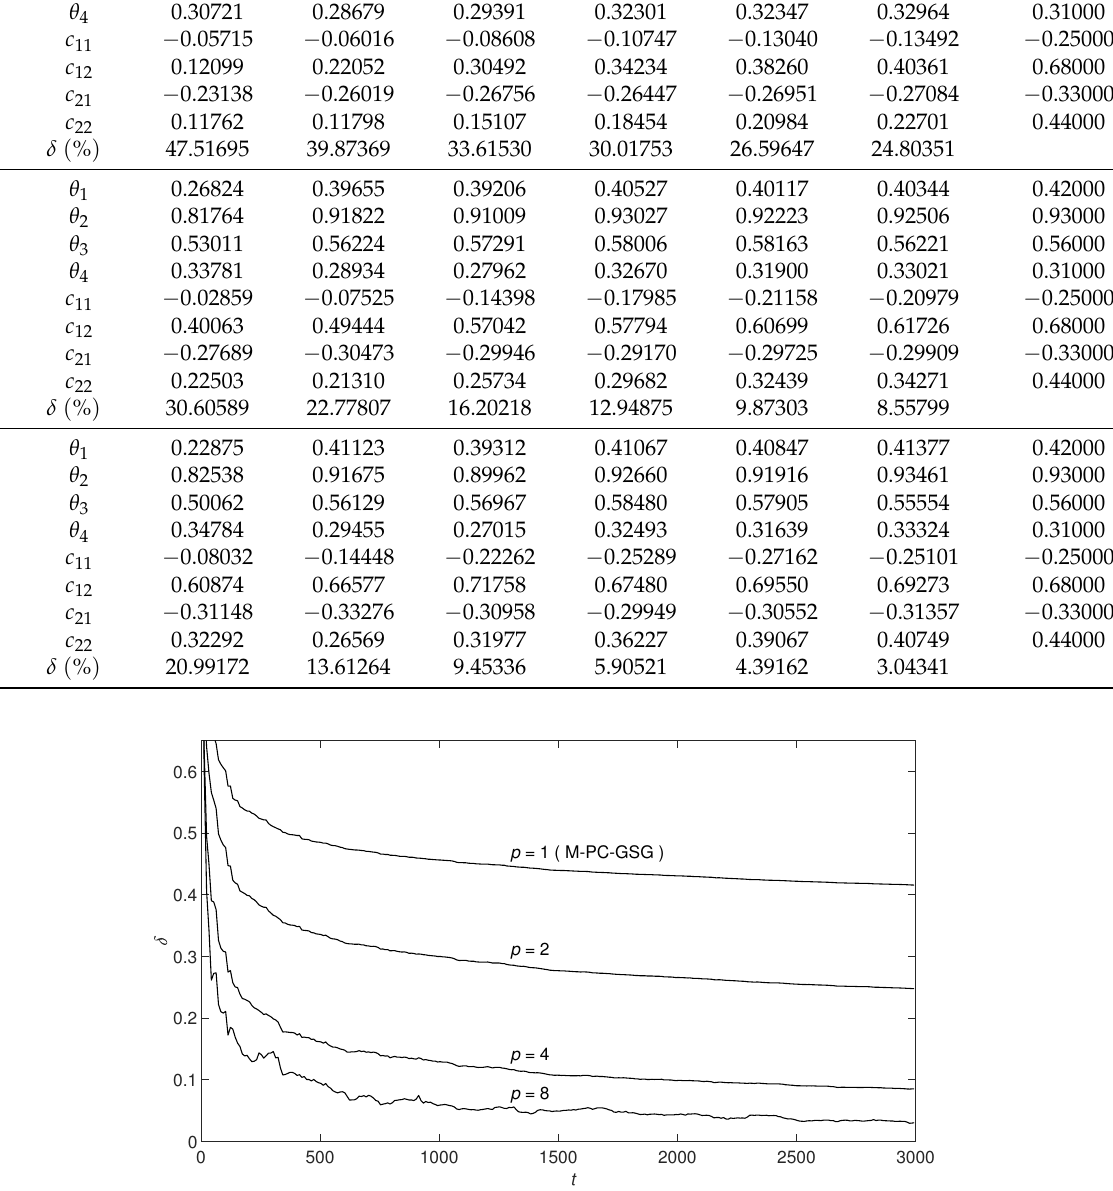
Figure 2. The M-PC-MI-GSG estimation errors versus t